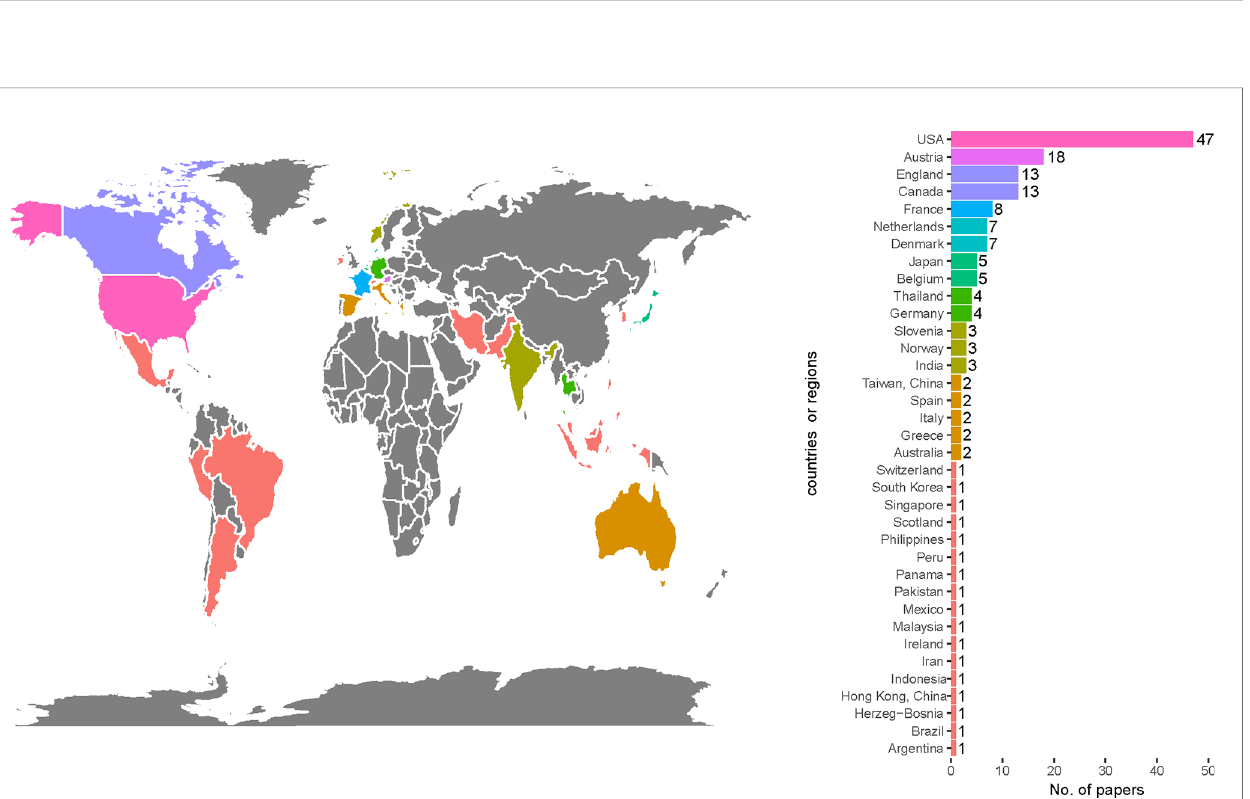
FIGURE 3 | Most frequent countries or regions participating in the 100 most cited papers in radiotherapy or concurrent chemoradiotherapy in cervical cancer between 1990 and 2020.